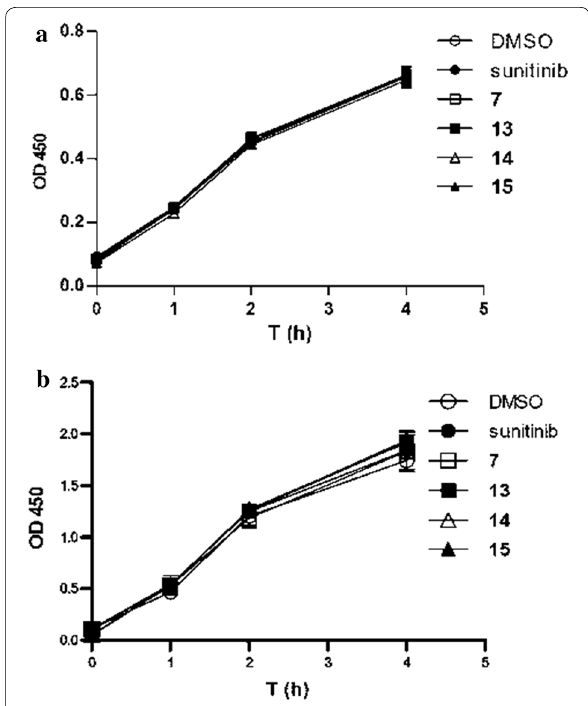
Fig. 2 Acute cytotoxicity assay of a HCT116; b Detroit 551 incubated with DMSO (1%), sunitinib, 7 , and 13 – 15 (10